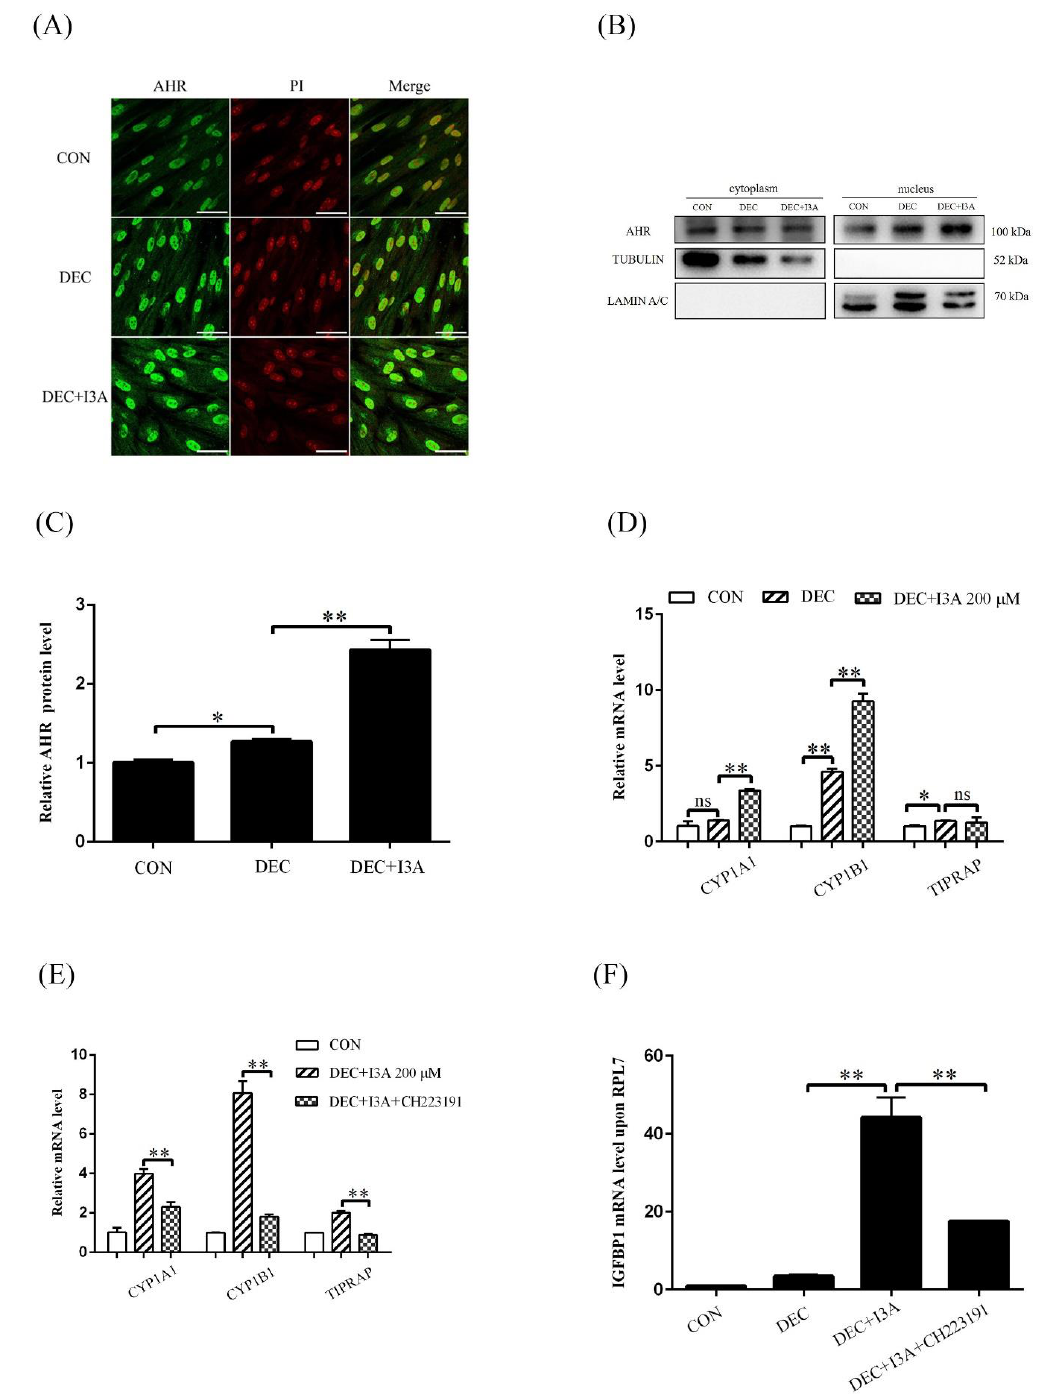
Figure 4. I3A promotes human in vitro decidualization by activating AHR. ( A ) AHR immunofluorescence in decidual cells after stromal cells were treated with 200 mM I3A for 4 days. ( B , C ) Western blot analysis of AHR protein level in cytoplasmic and nuclear fractions after stromal cells were treated with I3A for 4 days. ( D ) RT-qPCR analysis on the relative mRNA levels of CYP1A1 , CYP1B1 and TIPARP after stromal cells were treated with 200 μM I3A. ( E ) RT-qPCR analysis on the mRNA levels of CYP1A1 , CYP1B1 and TIPARP after stromal cell was treated with I3A and CH223191. ( F ) The mRNA level of IGFBP1 after stromal cells were treated with I3A and CH223191. Scale bar = 50 µ m. CON, control. DEC, decidualization. ns, no significance. *, p < 0.05; **, p <